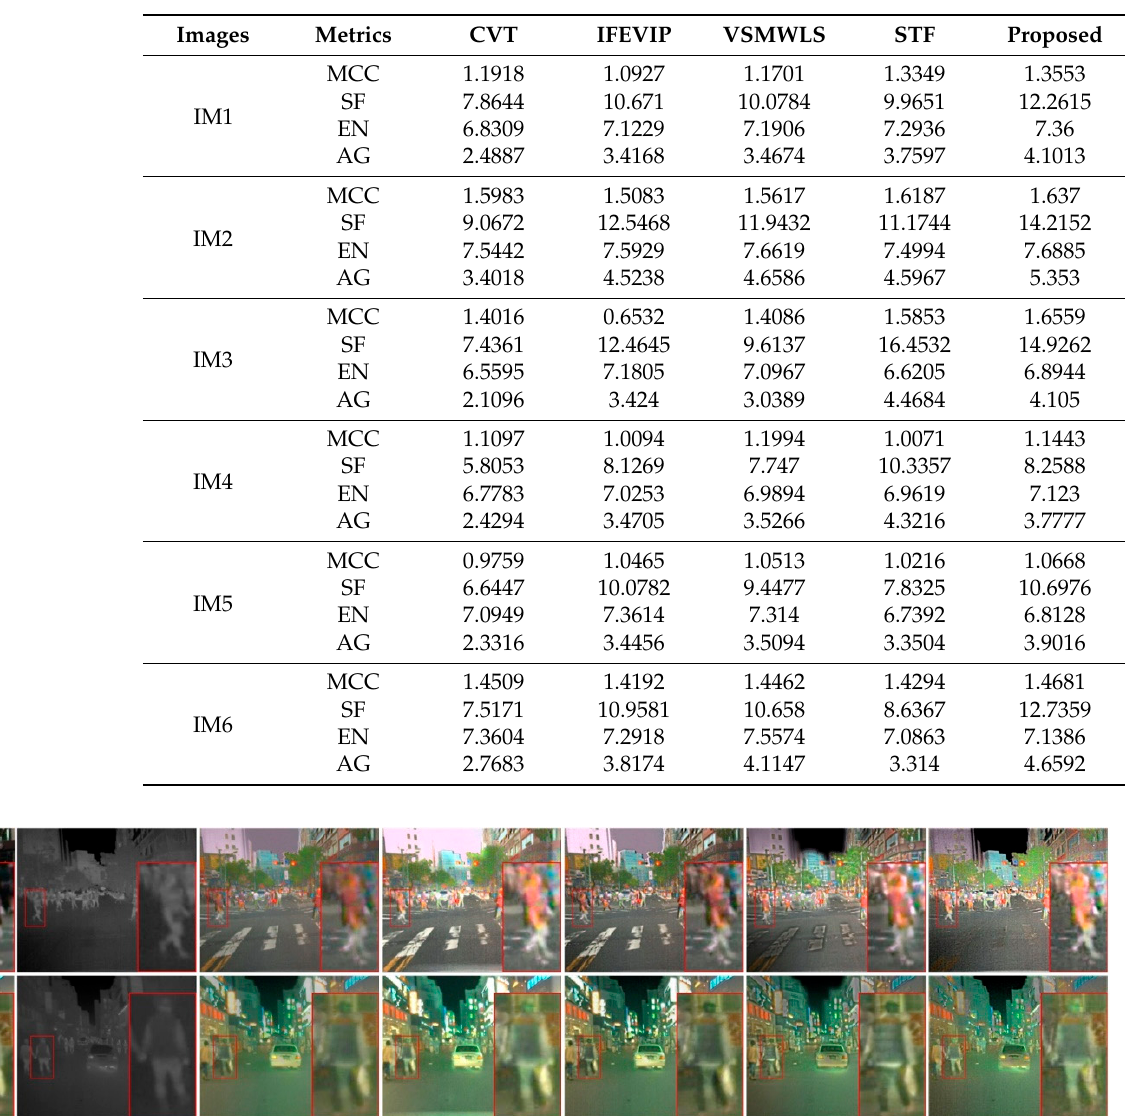
Table 1. Quantitative comparison of different fusion methods.